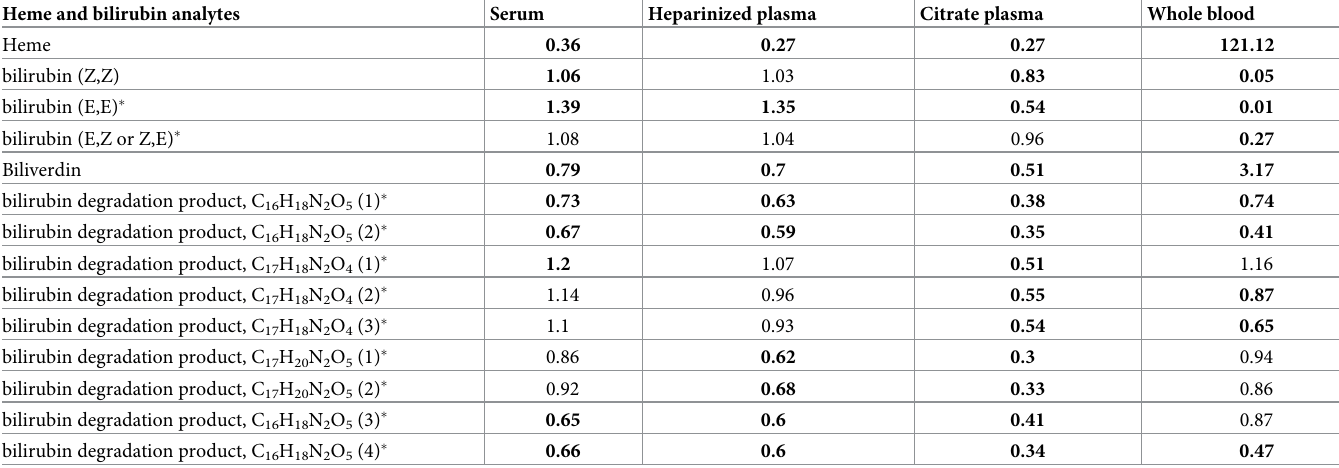
Values in bold font refer to statistically significant differences per matched-pair t-test analysis. � indicates a compound that has not been officially confirmed based on a standard, but we are confident in its